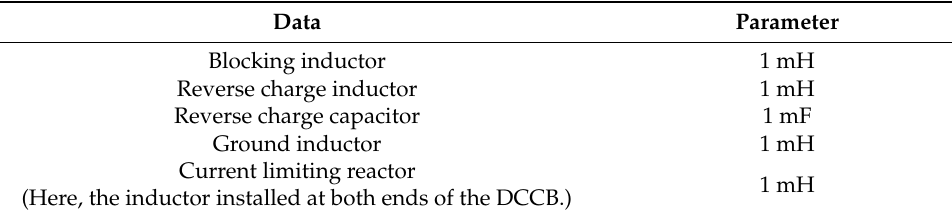
Table 2. Basic characteristics of the elements used to simulate the proposed DCCB.